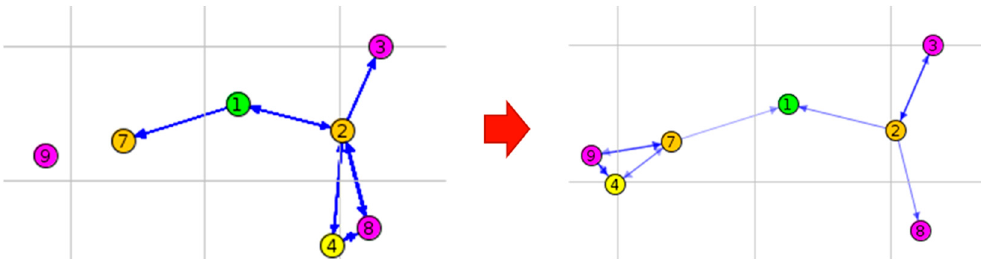
Figure 22. Simulation for the AA handover.